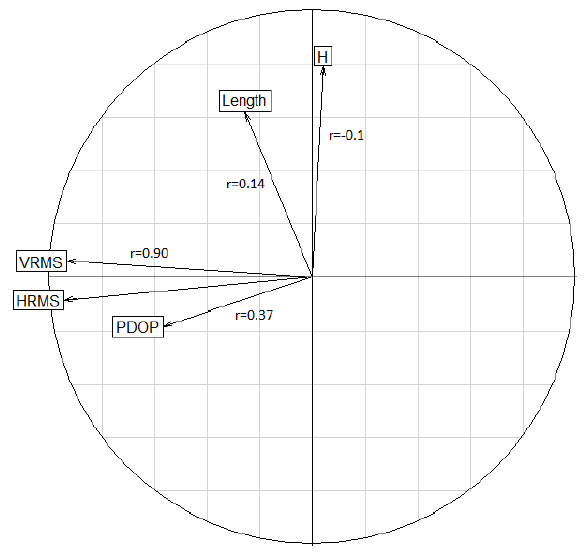
Figure 4: Projection of the quality variables of shape 2 in the first factorial plane